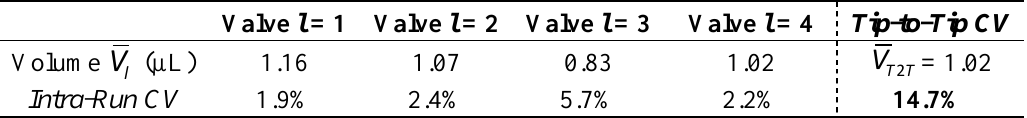
Table 3. Tip-to-tip experiments with L = 4 different valves. The runs were performed with water at a pressure of 400 mbar with an actuating time of 5 ms. The mean volume of all four valves is 1.02 µL, with a Tip-to-Tip CV of 14.7%.